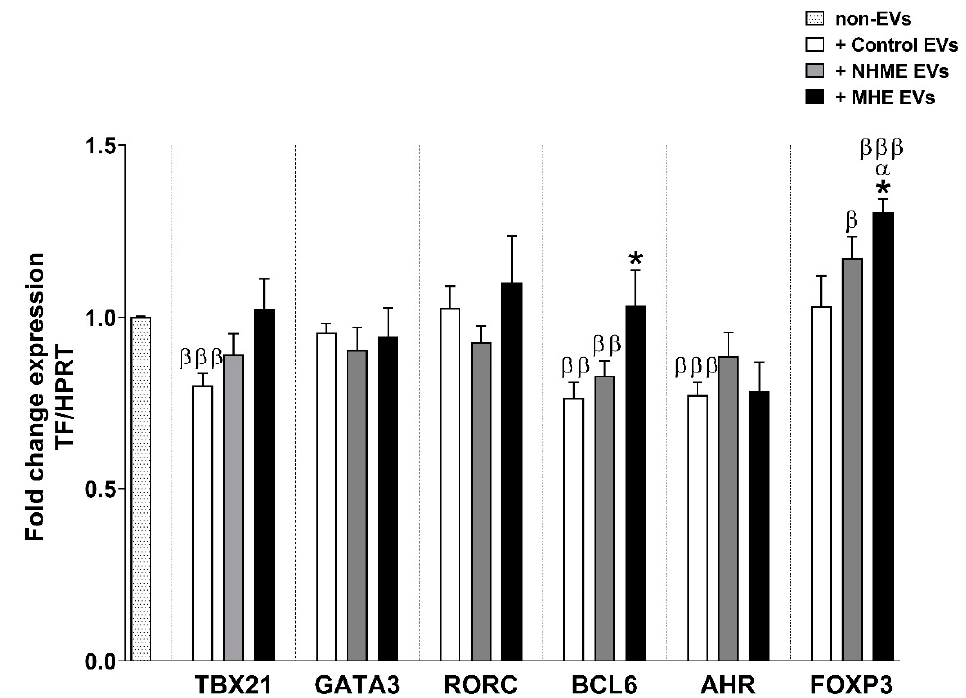
Figure 6. Transcription factor expression in CD4+ T cells after 5 days of treatment with human plasma EVs. After 5 days of CD4+ T cells cultured with plasma EVs from the control (control EVs), without (NMHE EVs) or with minimal hepatic encephalopathy (MHE EVs) subjects, the expression of TBX21, GATA3, RORC, BCL6, AHR, and FOXP3 were quantified by qPCR. A condition without exosome treatment was also included as a reference (non-EVs). Values are given as the normalized target gene amount relative to non-EV conditions, which were considered as 1. Values are the mean ± SEM. Eight independent experiments were conducted for all conditions. Values significantly different from the control EV condition are indicated by asterisks (*), from the NMHE EV condition by α and from the non-EV condition by β (*/ α / β : p < 0.05; ββ : p < 0.01; βββ : p <